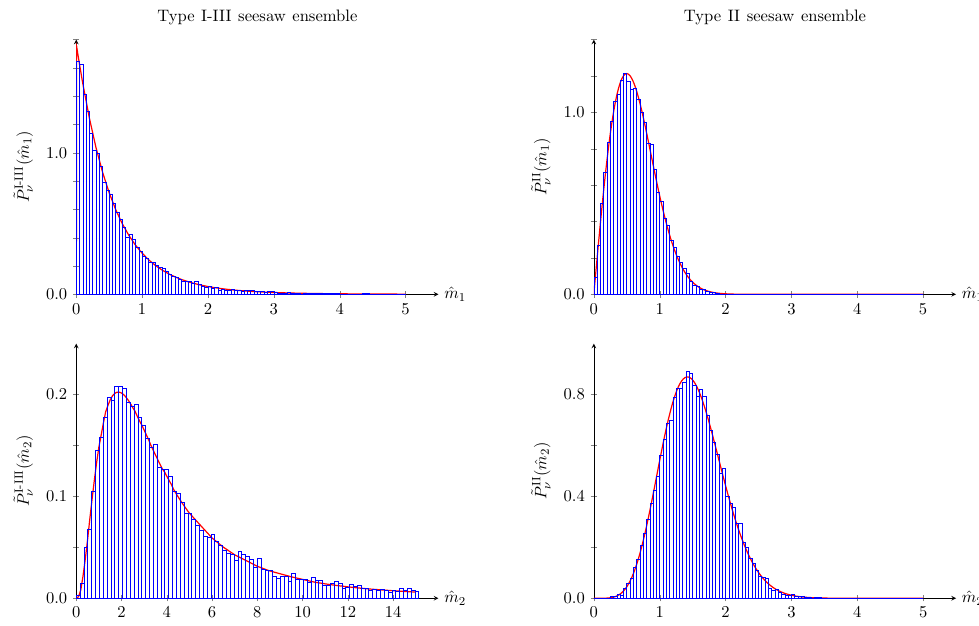
Figure 1 . Probability density functions for the singular values of the complex seesaw ensembles with N = 2. The red curve corresponds to the analytic result while the histogram corresponds to numerical results (with 2 : 5 10 4 dimensionless light neutrino mass matrices generated). The left (cid:2) and right columns show the pdfs for the type I-III and the type II seesaw mechanisms